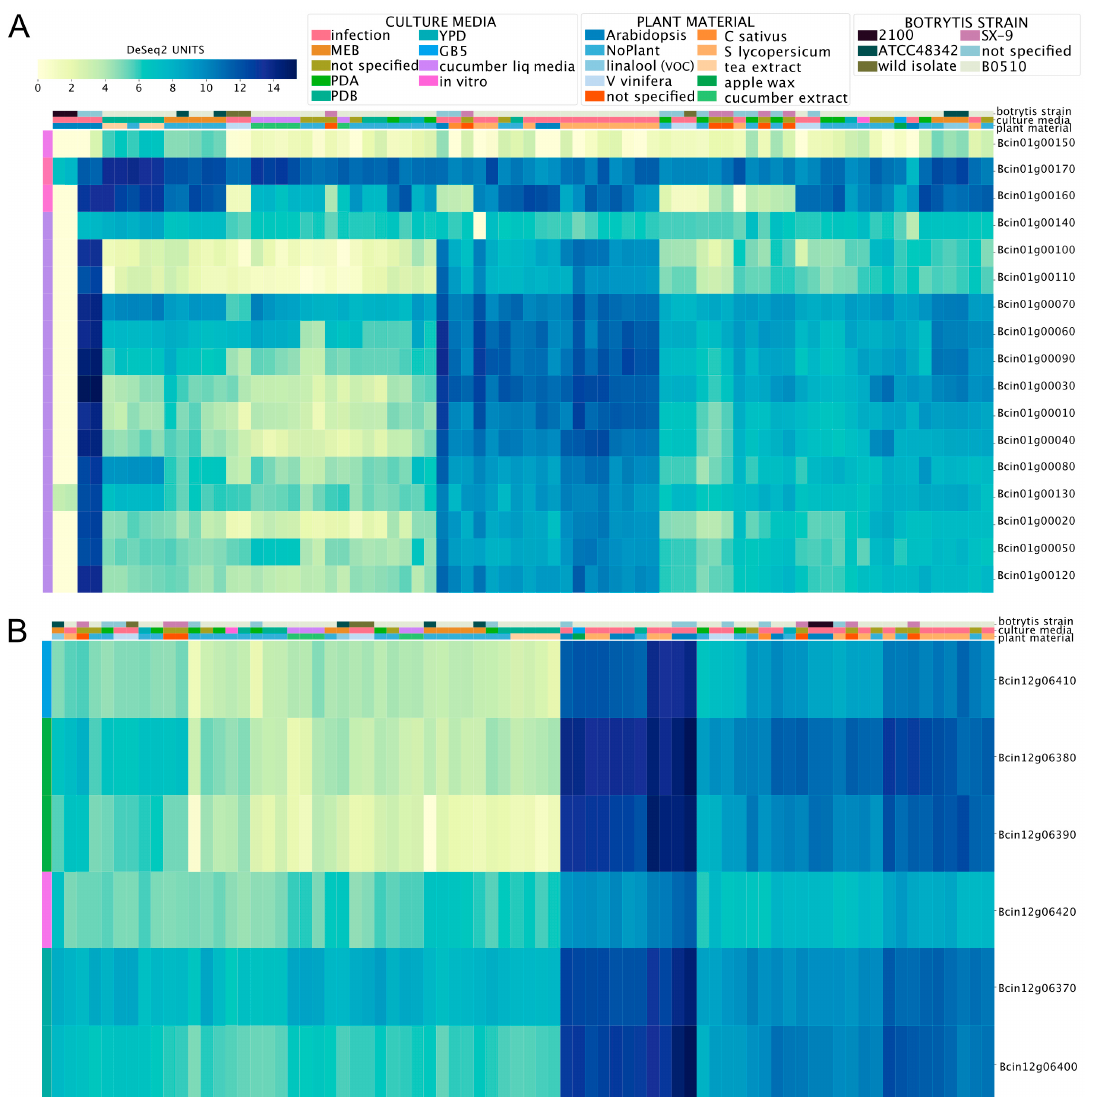
Figure 2. Expression patterns of gene clusters involved in the production of the phytotoxins botcinic acid ( A ) and botrydial ( B ) in B. cinerea . The heatmaps depict mRNA levels as calculated using DESeq2 (see Materials and Methods). The color scale represents the gene expression level from low to high (yellow to dark blue, respectively). The color code at the top of each heatmap indicates the culture media, plant material, and B. cinerea strain (key is shown above). Experimental conditions are indicated in each column, while genes are shown in each row. To streamline the overall figure, the description of each experiment was omitted from both heatmaps.